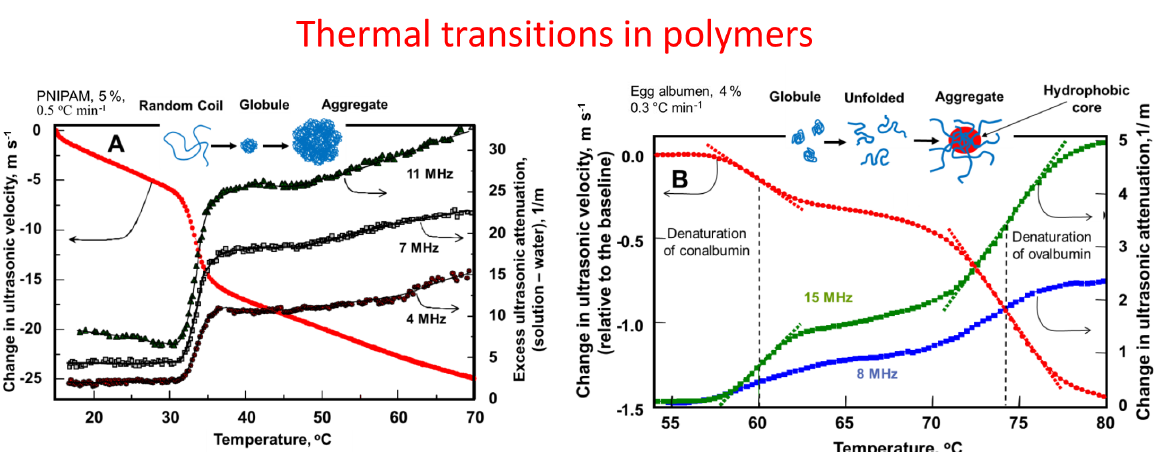
Figure 5. Ultrasonic monitoring of thermal transitions in polymers. (a) Thermal transition in aqueous solution of 5% w / w of poly(N- isopropylacrylamide), PNIPAM. HR-US 102 ultrasonic spectrometer (Ultrasonic Scientific, Dublin), temperature ramp mode, heating rate